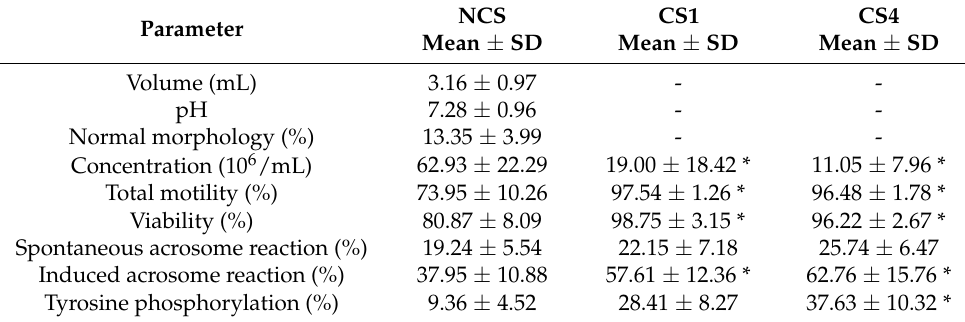
Table 1. Semen samples